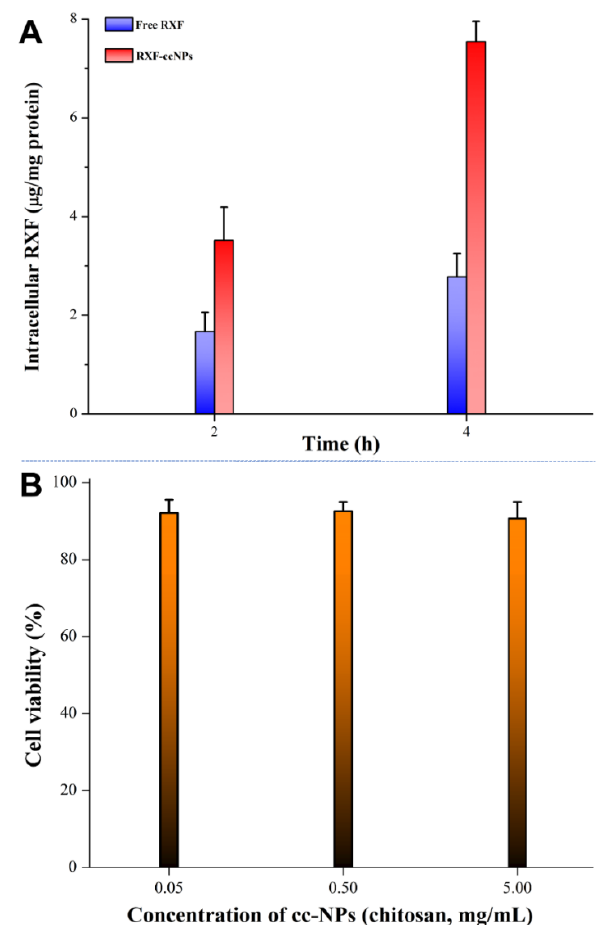
Figure 6. Cellular uptake quantified by intracellular RXF concentration ( A ) and cell viability of Caco-2 cells treated with ccNPs with different levels of chitosan ( B ).